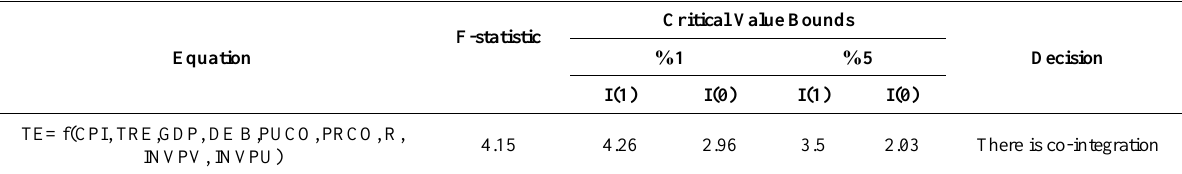
Table 6. Results of the co-integration